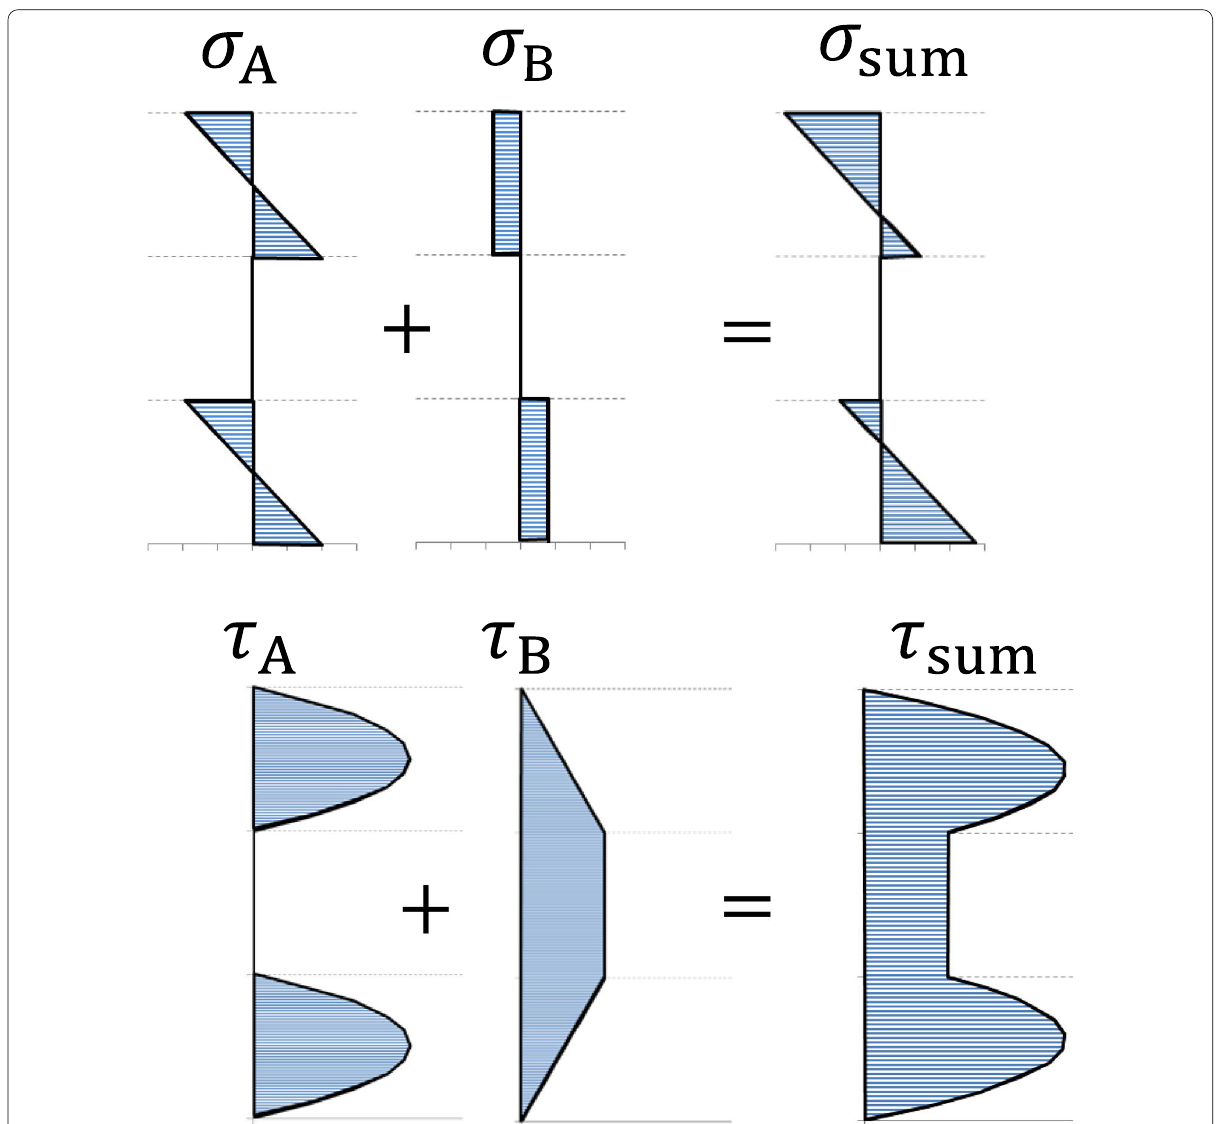
Fig. 10 Axial and shear stress of each layer calculated from the results of the shear analogy